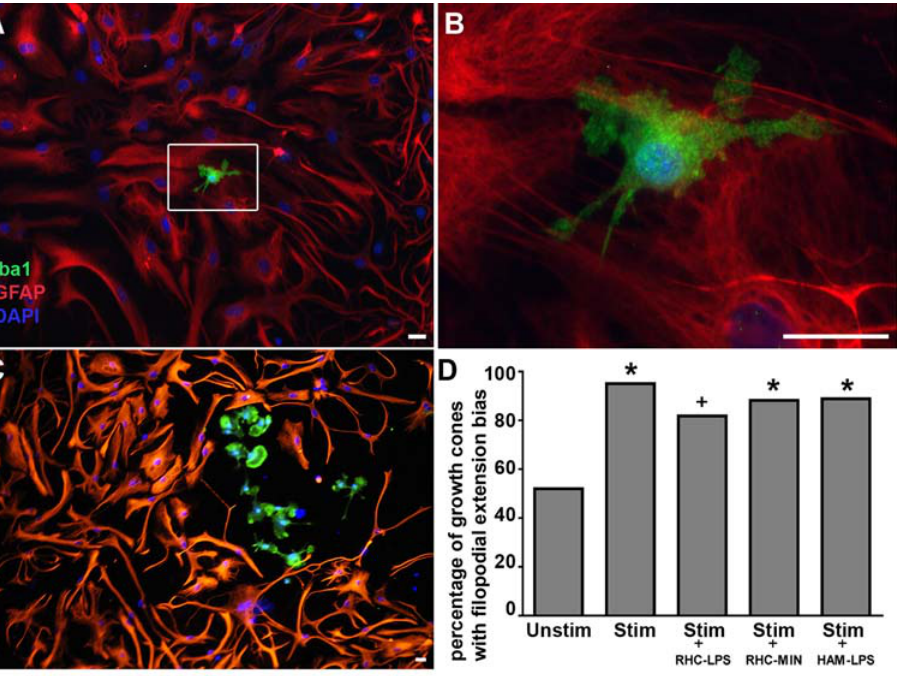
Figure 4. Activity-driven axon guidance in the presence of activated microglia and astrocytes. (a) Astrocytes and microglia in rat hippocampal cultures. Cultures were labeled using anti-Iba1 as a microglia marker (green), GFAP as an astrocyte marker (red), and were counterstained for nuclei with DAPI (blue). There were very few microglia in the cultures ( , 1 in 300, see text). (b) shows an enlarged panel of (a). (c) The few microglia that were present in our cultures sometimes formed clusters. (d) The attractive filopodia extension bias occurs in the presence of conditioned media from minocycline treated rat hippocampal cultures (RHC-MIN) (n=17) and LPS activated human adult microglia cultures (HAM- LPS) (n=18). This was also the case for conditioned media from LPS (RHC-LPS) activated rat hippocampal microglia and astrocytes(n=22). Asterisk indicates p , 0.05, cross indicates p , 0.06. Scale bars, 25 m m.